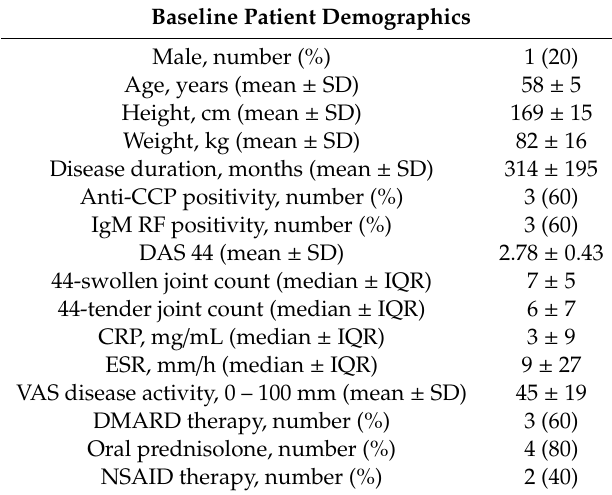
Table 1. Baseline patient demographics with clinical and functional